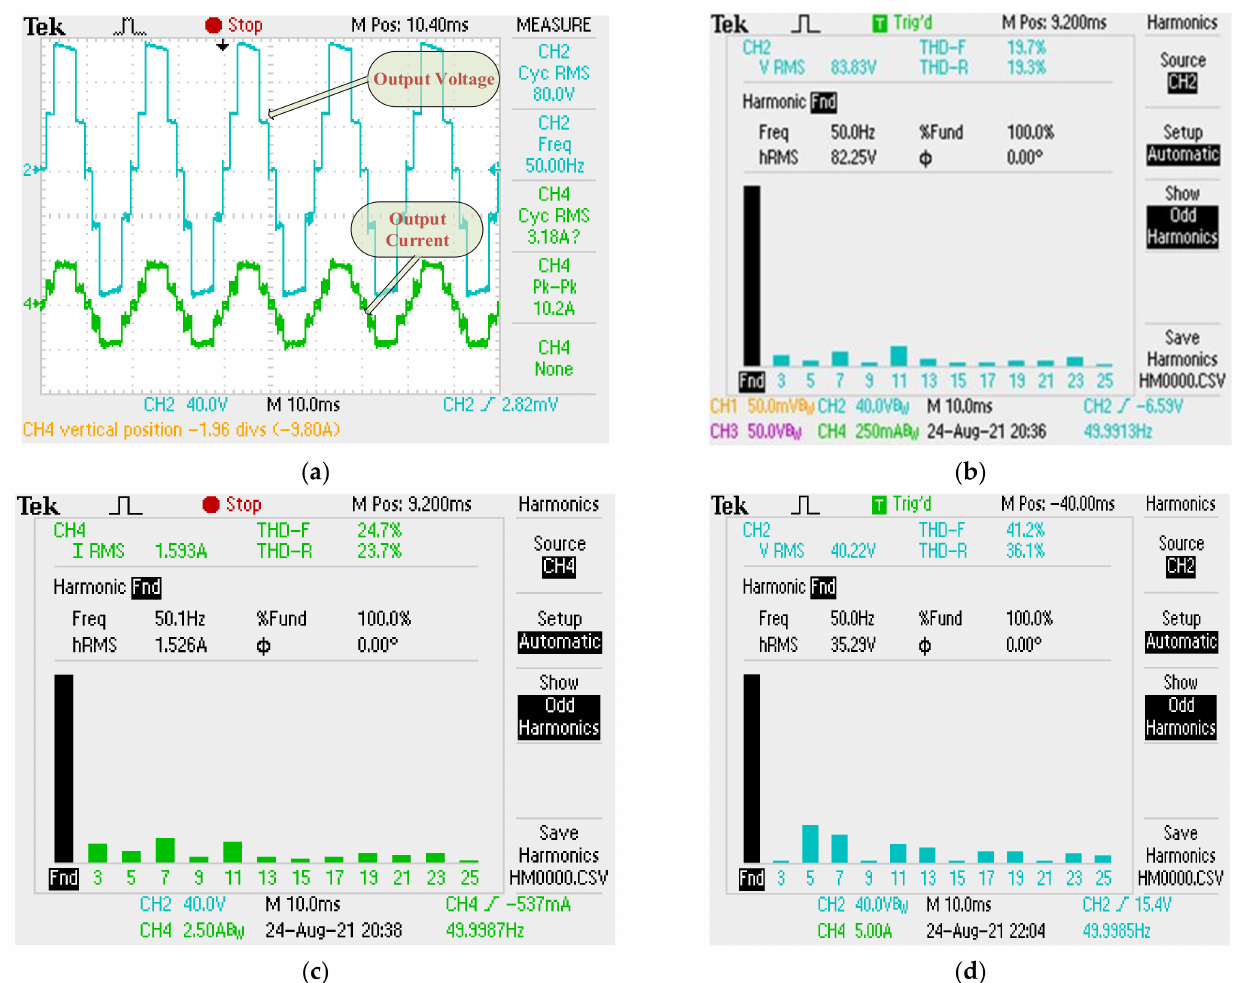
Figure 11. ( a ) Output voltage (V) and load current (A) during normal condition, ( b ) THD of output voltage for five-level, ( c ) THD of output current for five-level, and ( d ) THD of output voltage for